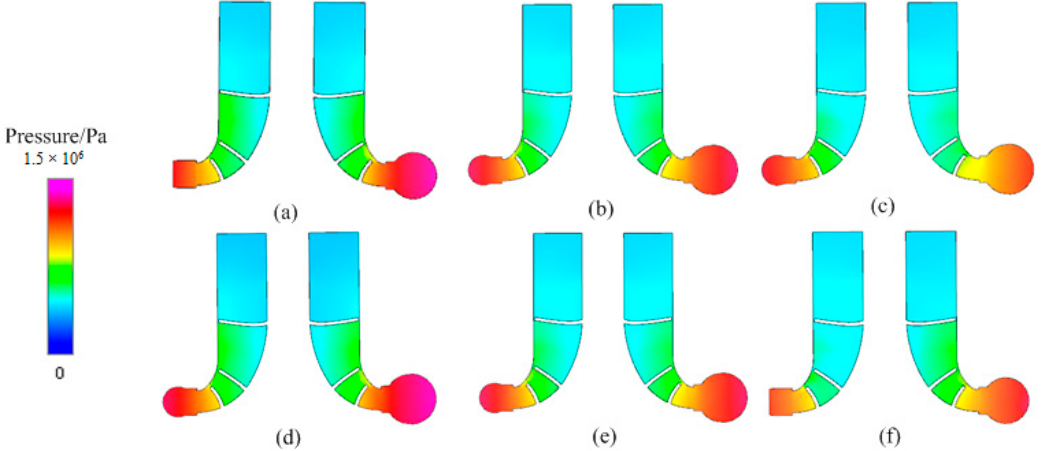
Figure 9. Comparisons of static pressure distributions at the radial section between the combination impeller and the conventional impeller: ( a ) combination impeller, 0.8 Q d ; ( b ) combination impeller, 1.0 Q d ; ( c ) combination impeller, 1.2 Q d ; ( d ) conventional impeller, 0.8 Q d ; ( e ) conventional impeller, 1.0 Q d ; ( f ) conventional impeller, 1.2 Q d .